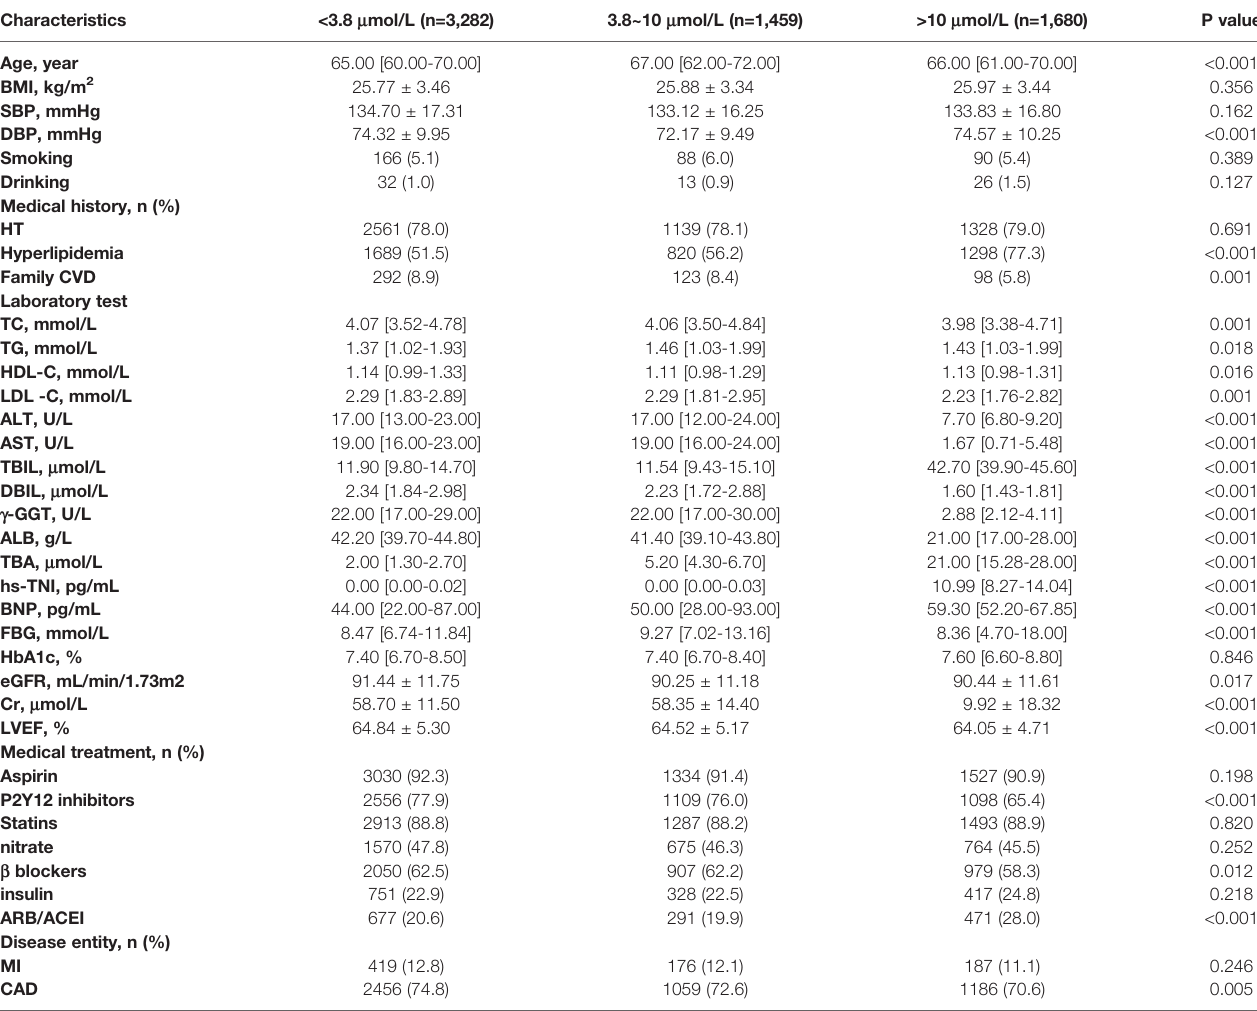
TABLE 4 | Characteristics of patients with T2DM in different TBA levels.